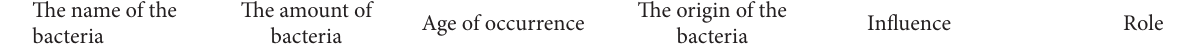
Table 1: The composition of human intestinal